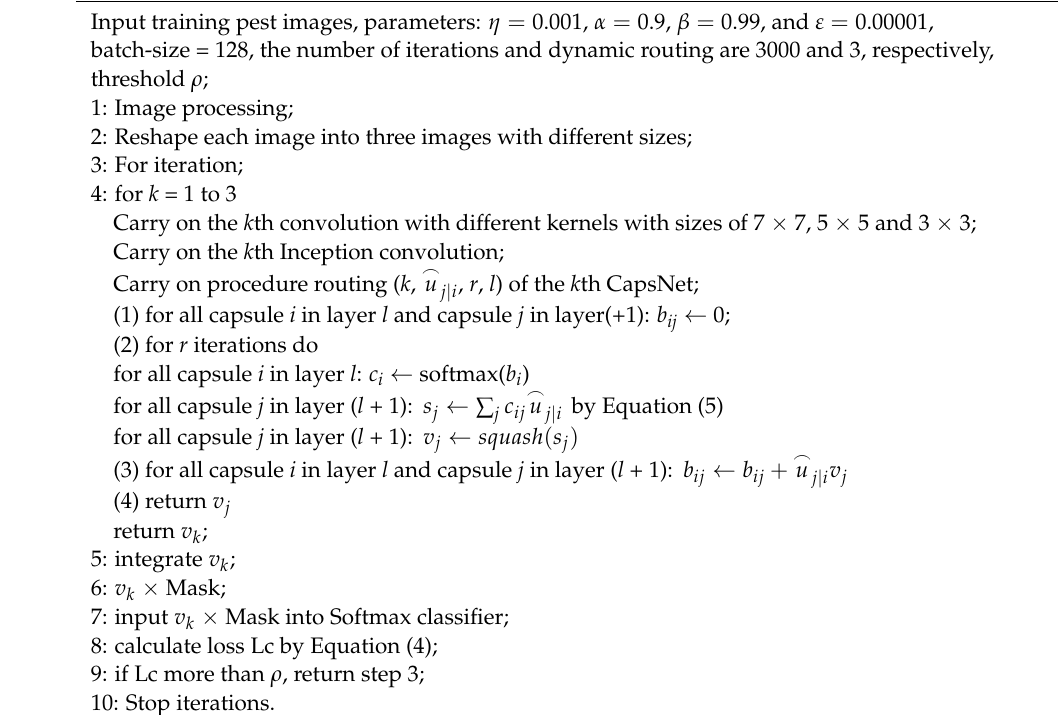
Algorithm 1: Multi-scale